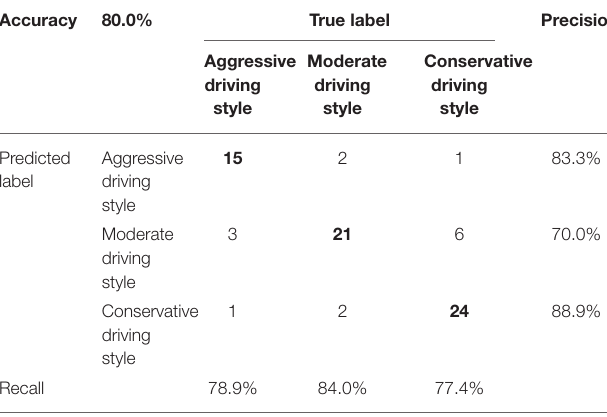
TABLE 3 | Confusion matrix of the SVM